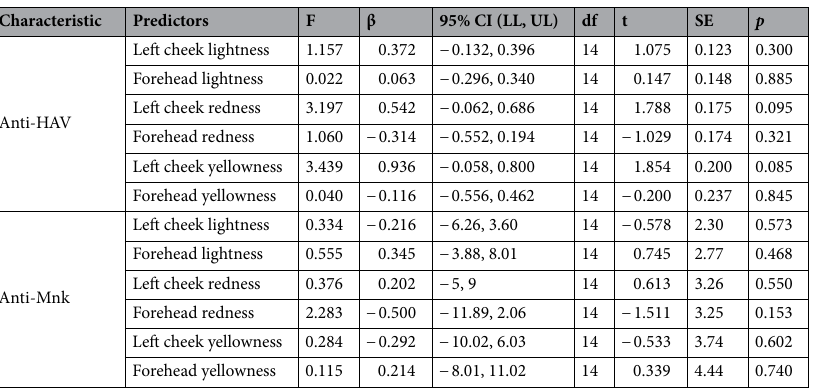
Table 3. Relationship between reactivity of the immune system and forehead and cheek lightness, redness, and yellowness. Anti-HAV antibodies against hepatitis A, Anti-Mnk antibodies against meningococcus. β represents a standardized β estimate.